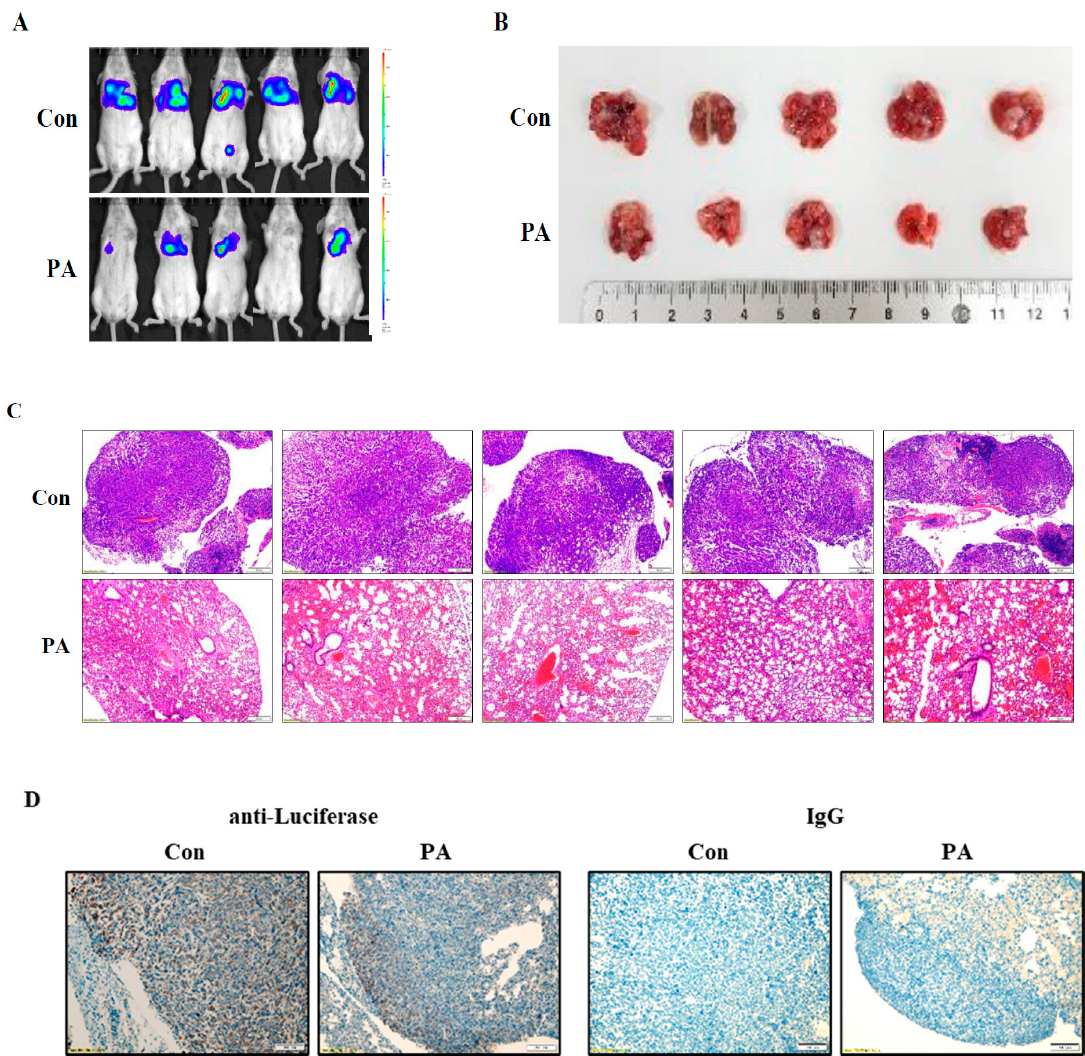
Figure 7. Effects of PA on lung metastasis in a syngeneic mouse model. ( A ) Luciferase-labeled 4T1 cells were pretreated with PA for 4 h and injected into the tail vein of syngeneic Balb/c mice ( n = 10). Bioluminescence images of luciferase expression were captured. ( B ) All mice were sacrificed after 4 weeks, and lungs were extracted. ( C ) Lung tissues were processed for immunohistochemistry of H&E staining. Scale bars = 200 µm. ( D ) Tumor tissues were fixed and stained either with anti-luciferase antibody or with nonspecific isotype IgG as a control. Scale bars = 200 µm. Similar results were observed in two independent experiments. Similar results were observed in two independent experiments.